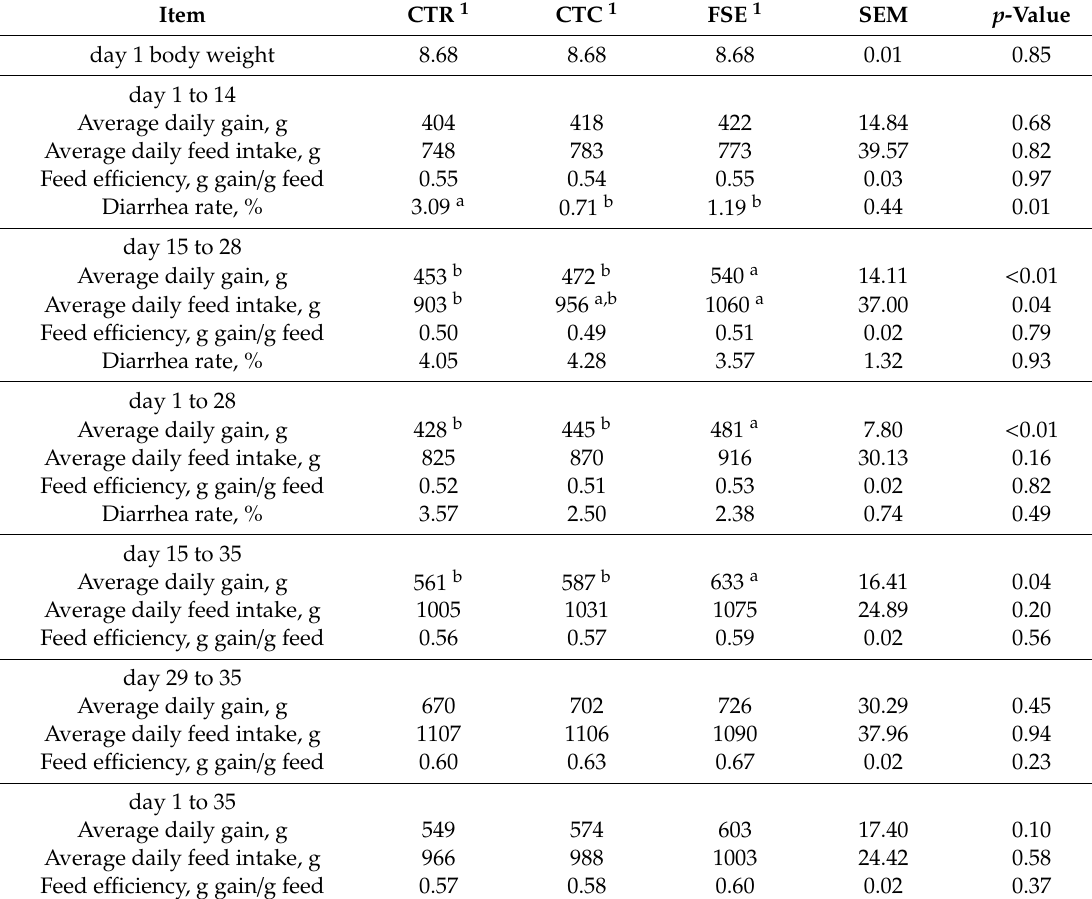
Table 2. E ff ects of Forsythia suspense extract on performance and diarrhea rate in weaned piglets.